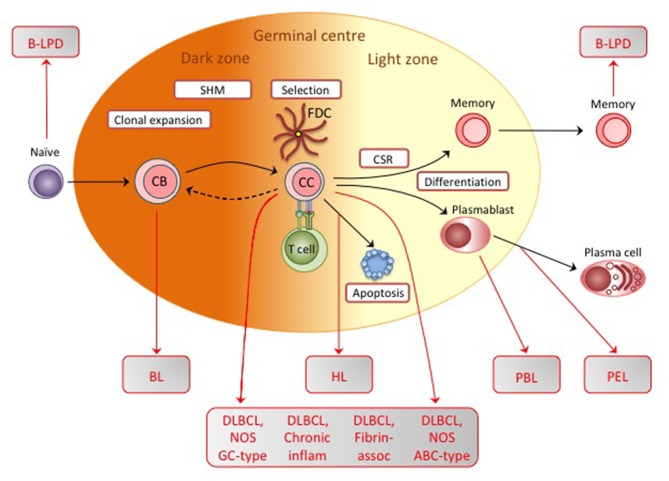
Diagrammatic representation of the germinal center (GC) reaction, showing the physiologic events involved in affinity maturation of antibody responses. Initially antigen-stimulated naïve B cells are induced into clonal expansion as centroblasts (CB), undergoing somatic hypermutation of immunoglobulin genes and producing a centrocyte (CC) population encompassing a range of variant sequences. This is an iterative process and may involve cells undergoing several rounds of CC/CB transition. Most centrocytes then die by apoptosis. Only those expressing immunoglobulin with increased affinity for the original antigen are able to escape by capturing antigen from the surface of follicular dendritic cells (FDCs) and attracting antigen-specific T cell help. Following class switch recombination (CSR) to generate different immunoglobulin isotypes, these centrocytes differentiate either into memory B cells or plasmablasts/plasma cells and leave the GC. Note that, although not shown on the diagram, memory cells in the recirculating pool may be recruited back into a germinal center reaction or directly driven to become plasma cells following re-exposure to antigen. EBV-associated B-LPD and B cell lymphomas display genotypic and/or phenotypic markers that indicate their origin from precursors at one or other position on this B cell differentiation pathway; here we show the presumed identity of those precursors for B-LPD, BL, HL, the various DLBCLs, PBL, and PEL.